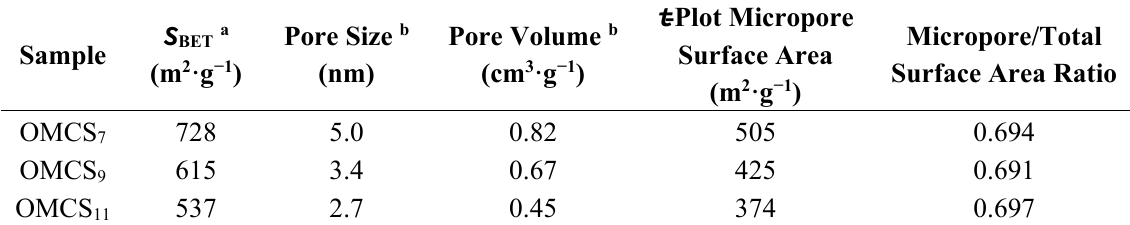
Table 1. The pore texture and specific surface area of OMCS x .